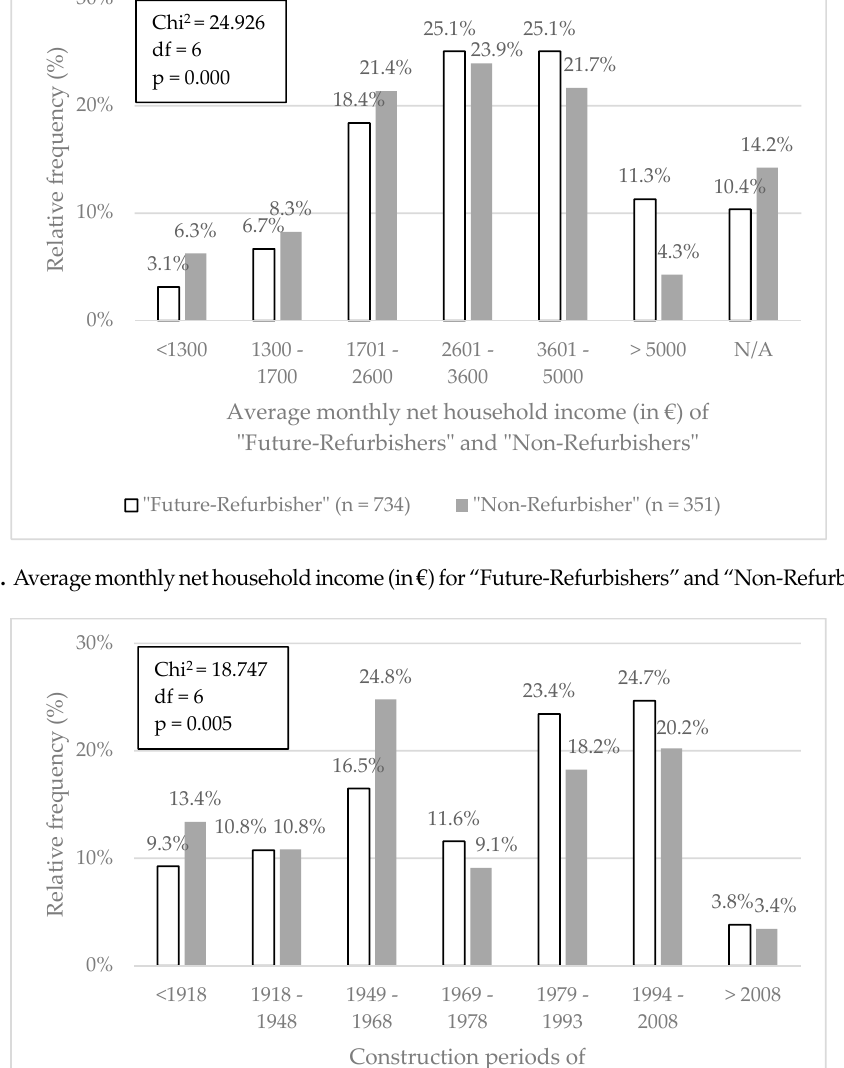
Figure 2. Education levels of “Future-Refurbishers” and “Non-Refurbishers”.